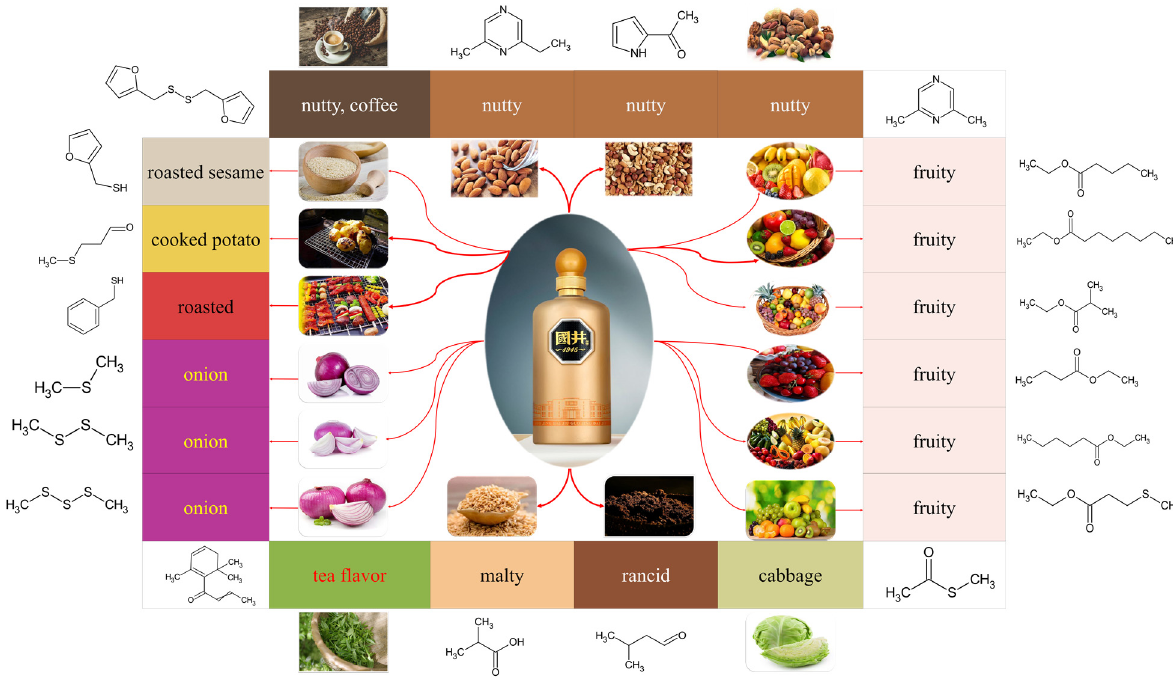
Figure 4. The key aroma components for the characteristic aroma of sesame flavor Baijiu.